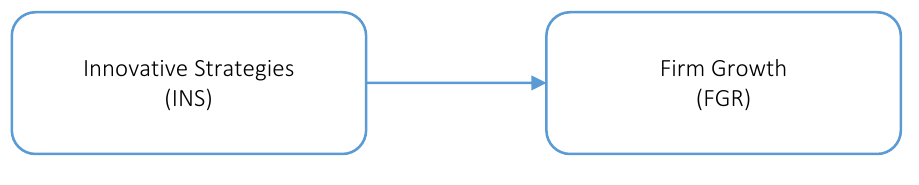
Figure 1. Simplified theoretical